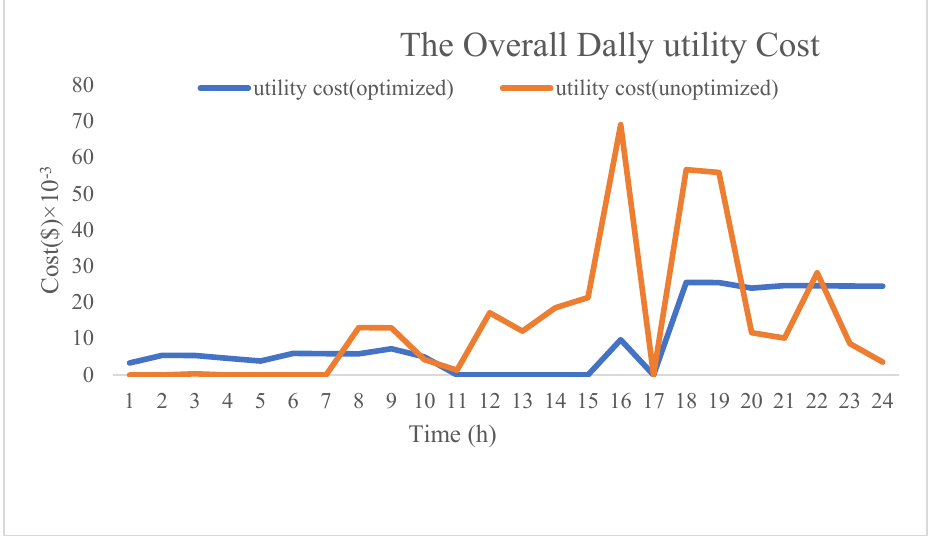
Figure 21. Total utility cost of the smart home after/before using the proposed HAEMS.